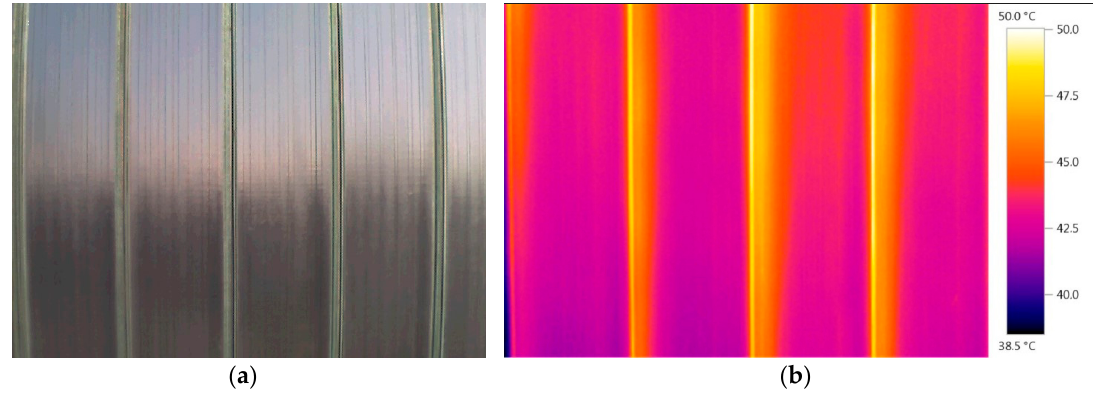
Figure 3. Normal ( a ) and infrared ( b ) photo of the external wall in the analyzed office.